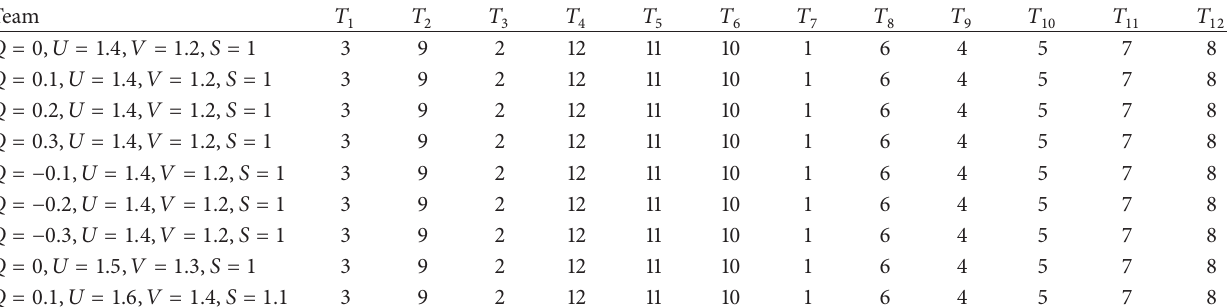
Table 5: Some ranking results with varied